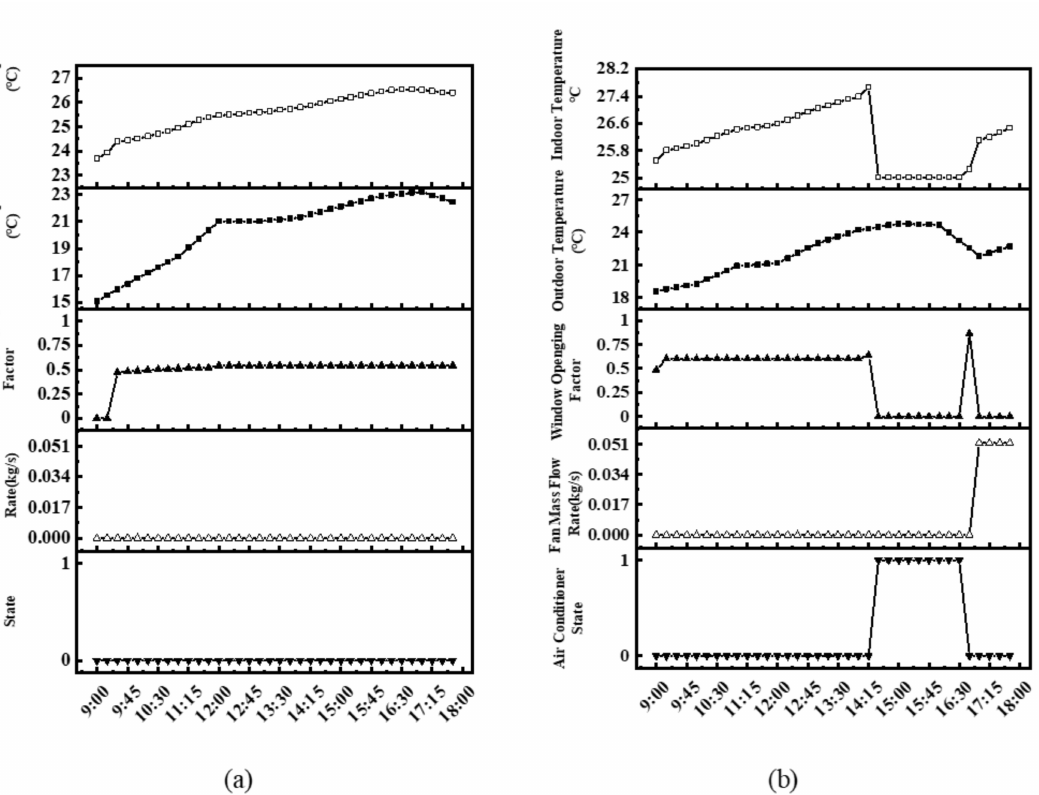
Figure 3. Simulation results of indoor temperature, window opening factor, fan air mass flow rate, and air conditioner on/off status according to the rule-based ventilation control strategy and outdoor temperature in a mild climate zone on 18 March and 18 May with 15 W/m 2 indoor equipment load: ( a ) 18 March; ( b ) 18